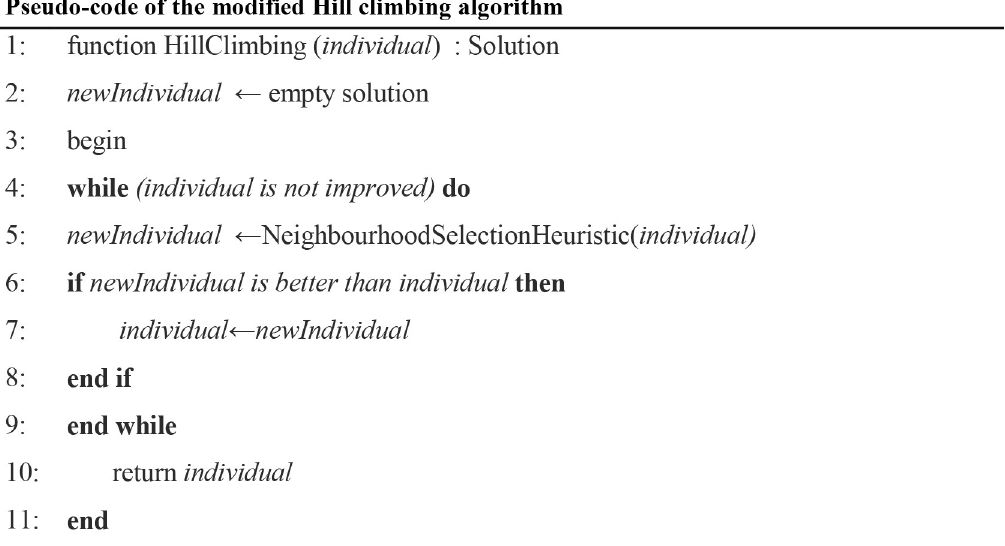
Fig 8. Pseudo-code of the modified Hill climbing